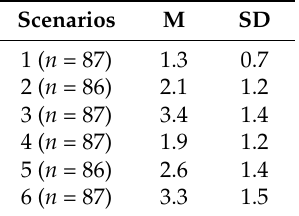
Table 2. Perceptions on Ethicality Concerning Various Types of Help